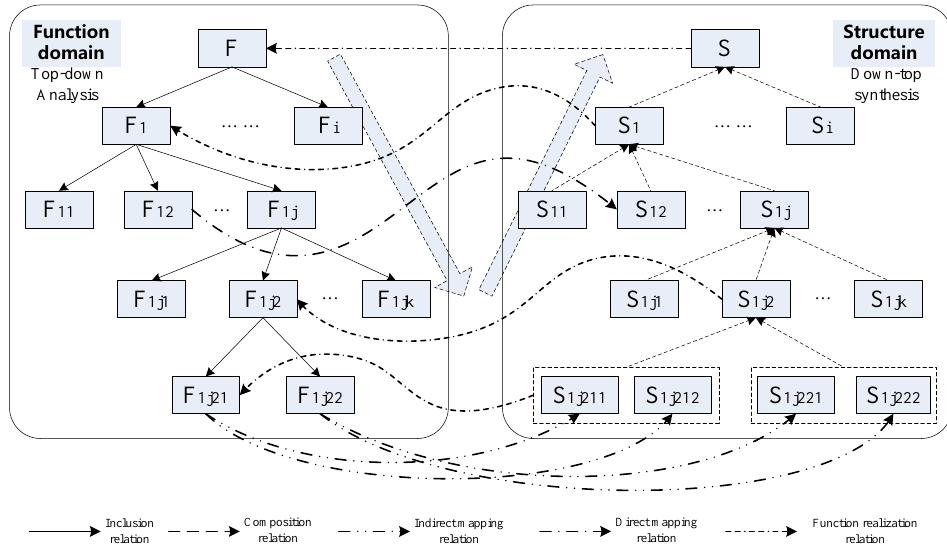
Figure 6. The cross-mapping model of function and structure.